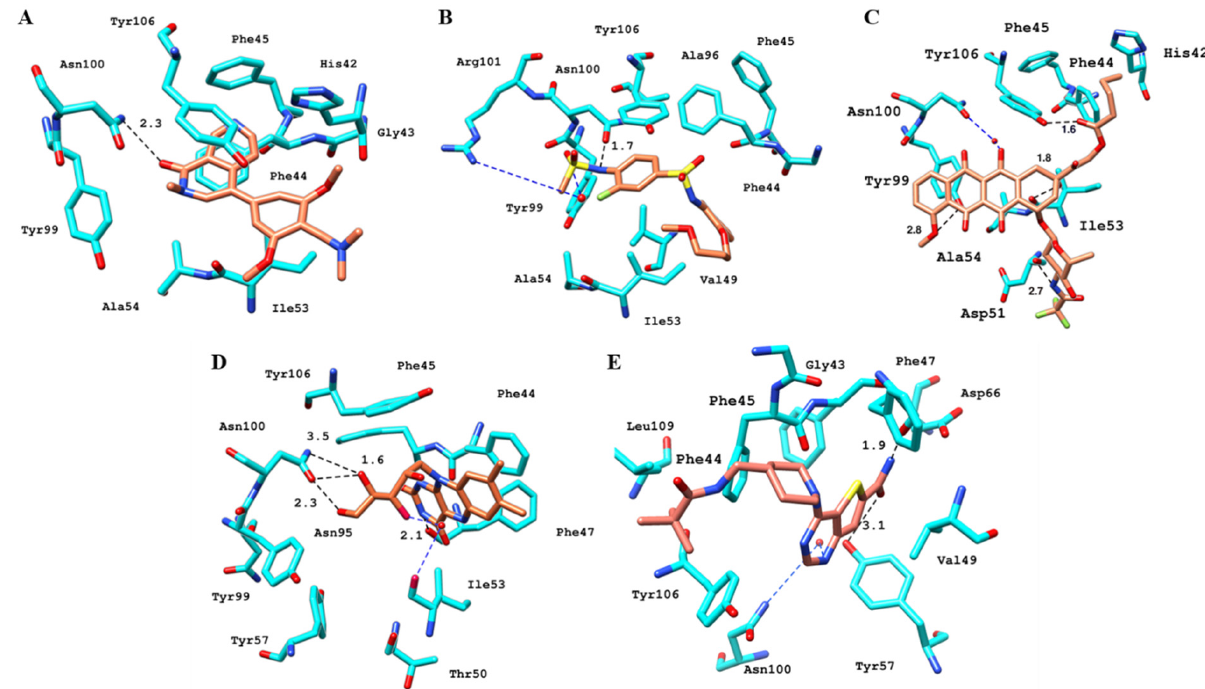
Figure 19. Post-MD interactions pattern of BRD9 (cyan) with ( A ) reference, ( B ) ZINC433599781, ( C ) ZINC282232750, ( D ) ZINC2036848, and ( E ) ZINC95589781 [17].